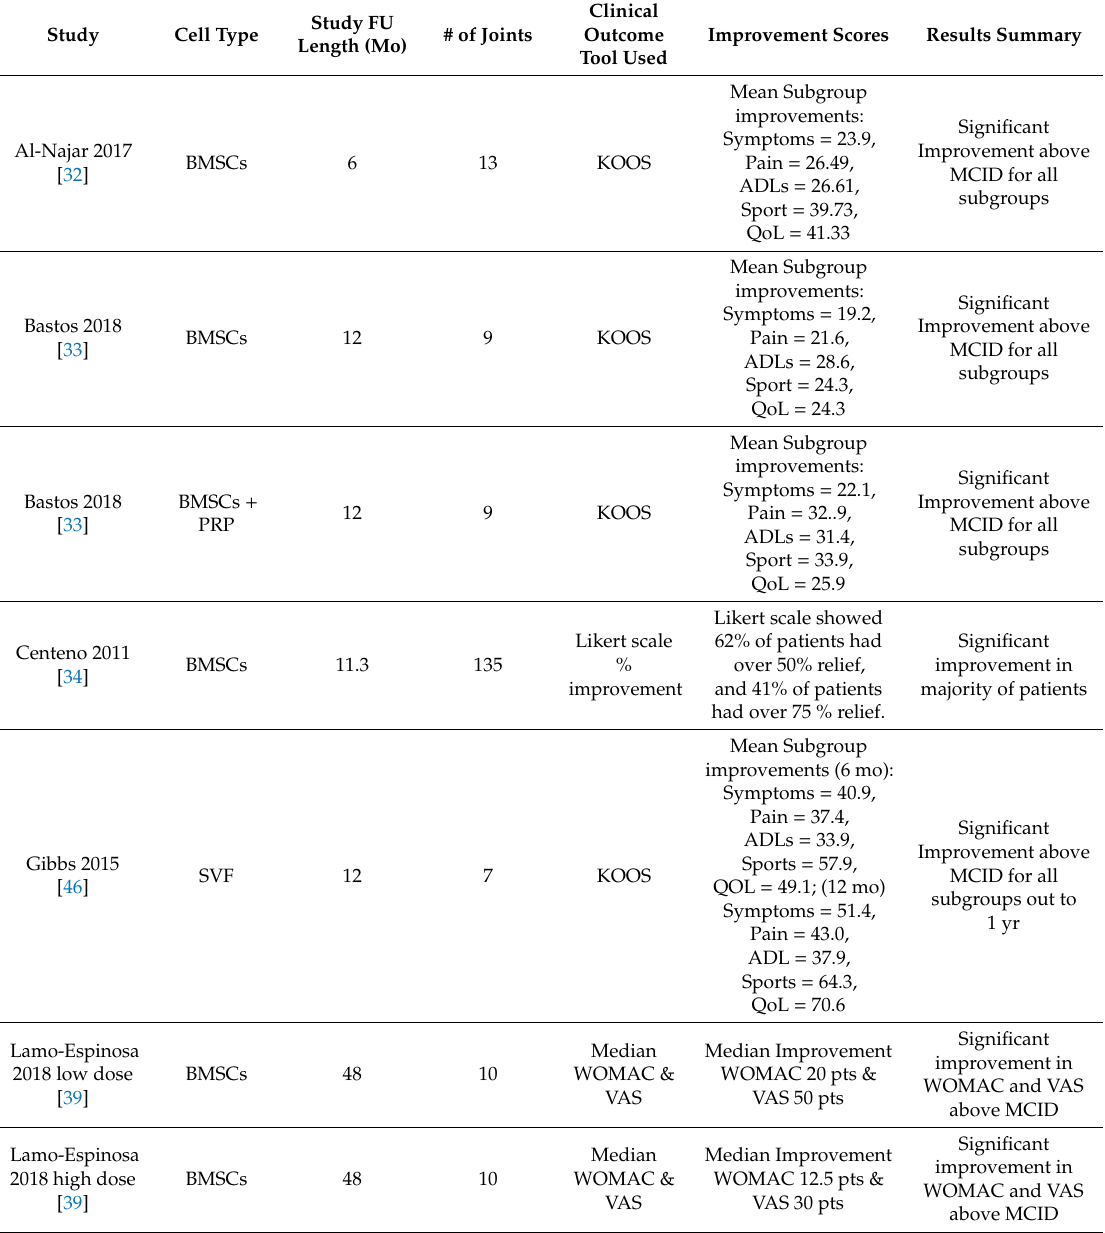
Table 2. Studies in Group 2, including outcomes, scores used and